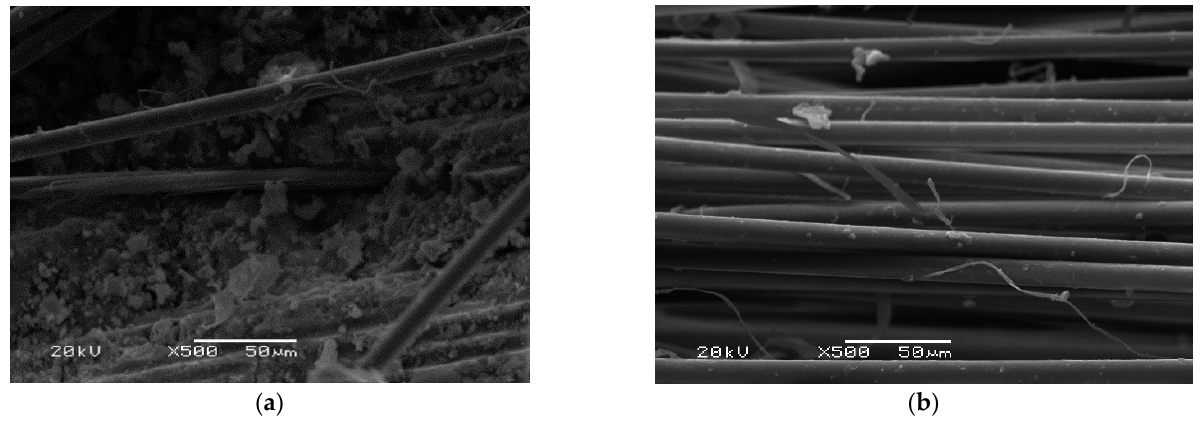
Figure 16. Aramid fiber in the fly ash matrix: ( a ) after the first series of bending tests; ( b ) after the second series.